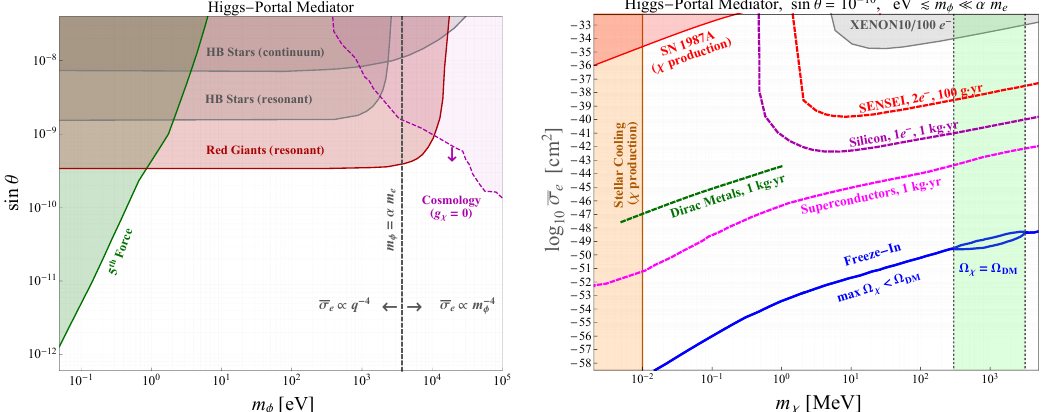
Figure 5 . Left: available parameter space for a light, Higgs-mixed scalar particle plotted along- (cid:13)(cid:13) decays [40] side constraints from 5th forces [10, 35{39], stellar cooling [26], and late time (cid:30) ! labeled \Cosmology". The vertical line represents the approximate boundary where the (cid:31)e scat- tering rate undergoes a parametric shift for scattering o(cid:11) atomic electrons, which is taken to be the reference value for presenting di(cid:11)erent techniques in [4]. For other materials with di(cid:11)erent characteristic momenta, this shift takes place for di(cid:11)erent values of m (cid:30) . Note that the cosmological bounds from [40] assume only a single (cid:30) without any additional contributions from the presence of an additional dark sector; including these contributions would only serve to strengthen these bounds, which further motivates values of m (cid:30) < (cid:11)m e . Right: constraints and projections for the (cid:31)e cross section for sub-GeV DM. Some representative projections for the SENSEI 2 e (cid:0) , Silicon 1 e (cid:0) , and superconductor targets are taken from [4], and the Dirac metals projection is from [15]; all projections assume (cid:10) (cid:31) (cid:10) DM . For points outside the green vertical band, the blue curve depicts (cid:27) e where sub-Hubble production as described in section 3 generates the maximum (max (cid:10) (cid:31) = (cid:10) DM ) (cid:2) fractional abundance (max (cid:10) (cid:31) < (cid:10) DM ) for each m (cid:31) . Inside the vertical green band, the blue curves represent (cid:27) e evaluated at g (cid:31) for which the full DM abundance can be accommodated; note there are two such values as depicted in (cid:12)gure 4 and on the right panel of (cid:12)gure 3. Although the Higgs portal mixing sin (cid:18) = 10 (cid:0) 10 may seem ad-hoc, this is chosen as a representative viable value near the stellar cooling exclusion region depicted on the left panel of this (cid:12)gure.